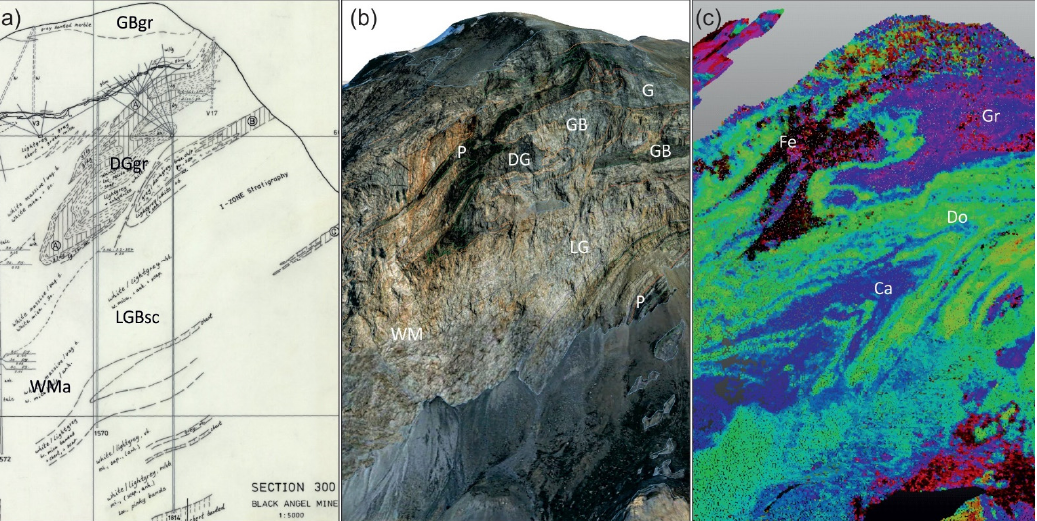
Figure 5. Integrated stratigraphy. ( a ) Drill-core stratigraphy from the NE-SW oriented Section 300 of Cominco database (after van der Stijl 1984): WMa: White Massive Marble + anhydrite; LGBsc: Light-Grey Banded Marble + scapolite; DGgr: Dark-Grey Marble + graphite; GBgr: Grey-Banded Marble + graphite; P: Pelite/chert; ( b ) RGB stratigraphy: WM: White Massive Marble; G: Grey Marble; GB: Grey Banded Marble; LG: Light-Grey Marble; DG: Dark-Grey Marble; P: Pelite; ( c ) Hyperspectral stratigraphy: Ca: Calcite-rich; Do: Dolomite-rich; Fe: Iron-rich; Gr: Graphite-rich.